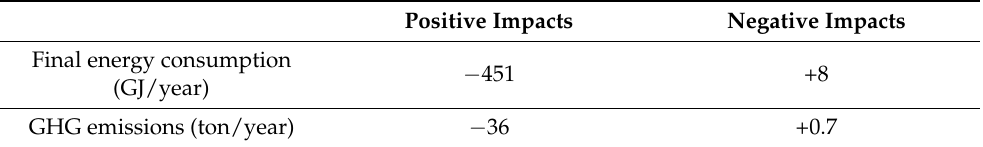
Table 6. Final energy consumption MJ/year and GHG emissions savings (negative values).